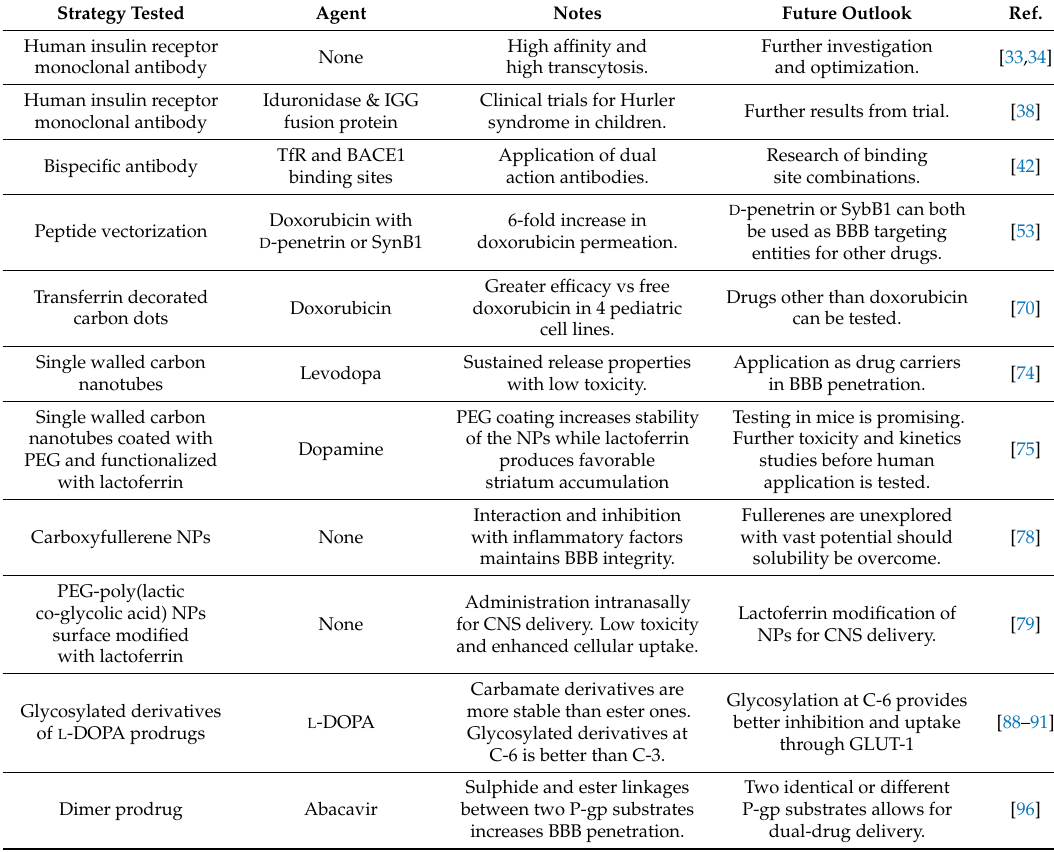
Table 1. Select works in improving CNS penetration reported in this